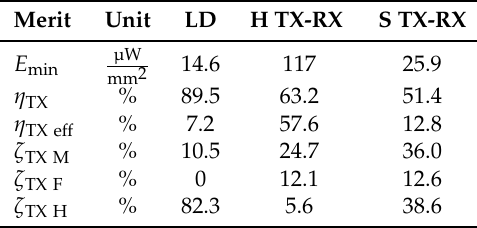
Table 2. TX merits for the laser diode (LD), the hybrid TX-RX system (H TX-RX) and the separated TX-RX lens system (S TX-RX).